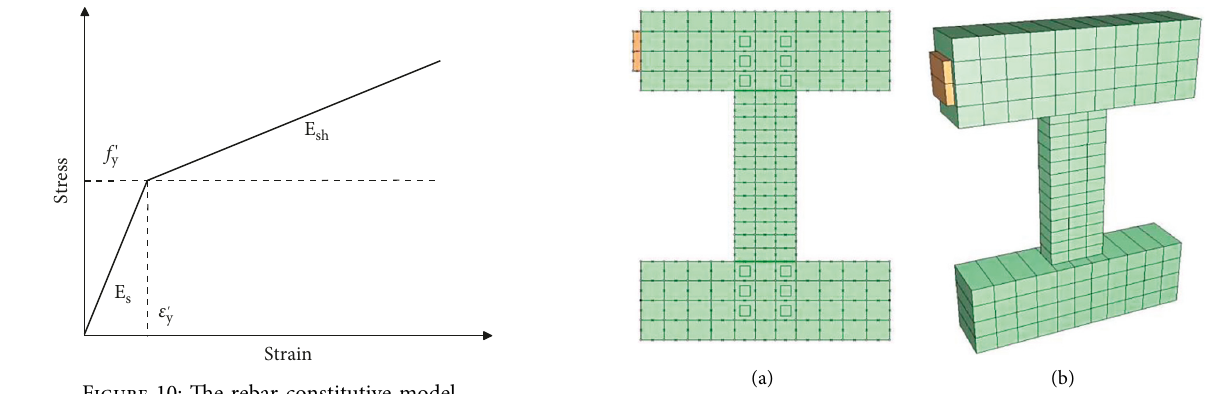
Figure 11: Meshing of the single connecting beam. (a) Meshing of two-dimensional view. (b) Meshing of three-dimensional